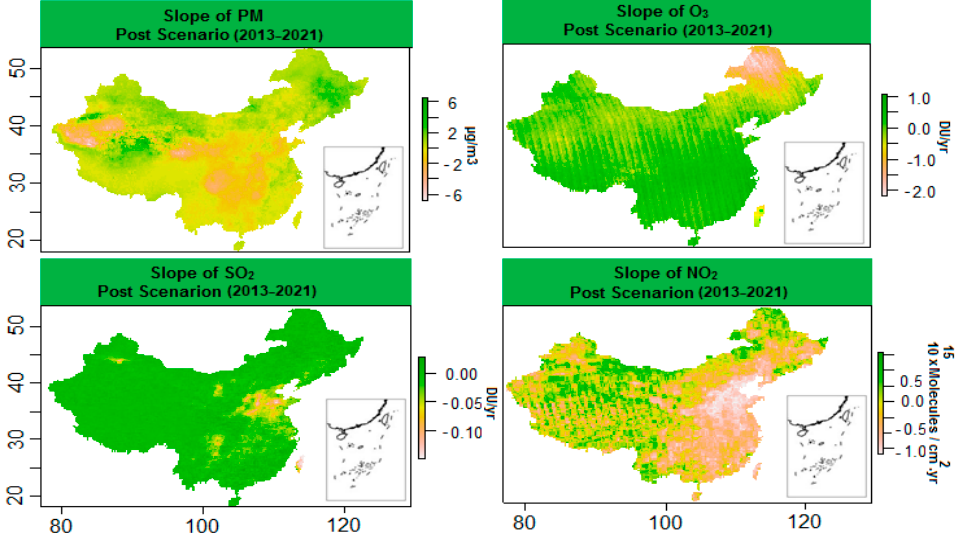
Figure 6. Slope of air pollutants for the post-scenario period (2013–2021).